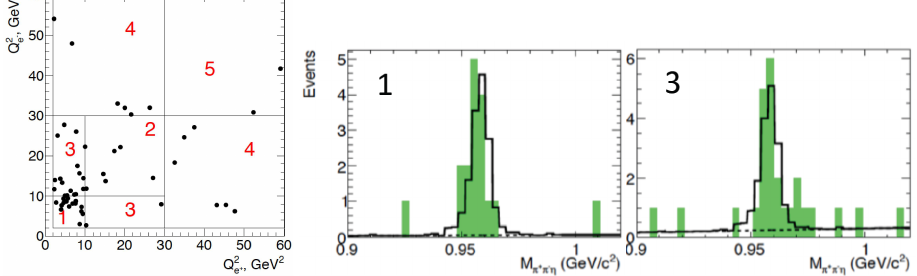
Figure 5. (left) The intervals in Q 2 versus Q 2 used for the γ ∗ γ ∗ → η (cid:48) TFF measurement. (right) e + e − Distribution of data (solid, green histograms) and fit results (solid curve) for the signal and background components in regions 1 and 3. The dashed curve shows the fitted prediction for the